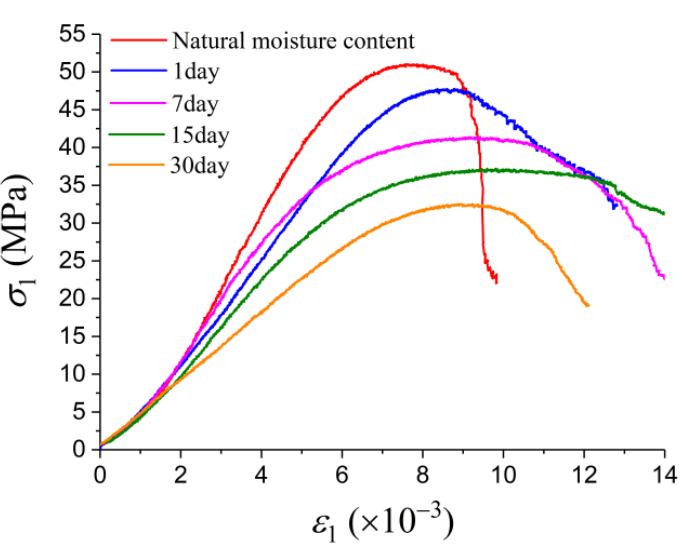
Figure 8. The stress-strain curves of the gypsum rocks after immersion in water for different durations. The relationship between the triaxial compressive strength and the water content of gypsum rock is shown in Figure 9, which indicates that the triaxial compressive strength of the gypsum rock declined with the increase in soaking time. After soaking in water for 30 days, the average compressive strength decreased significantly from 51.08 MPa to 31.21 MPa. After immersion in water for 1 day, the triaxial compressive strength of the gypsum rock was 48.87 MPa, this being 4.33% lower than that in the natural state. After immersion in water for 7 days, the triaxial compressive strength of the gypsum rock was 41.64 MPa, this being 18.48% lower than that in the natural state. After immersion in water for 15 days, the triaxial compressive strength of the gypsum rock was 36.56 MPa, this being 28.43% lower than that in the natural state. After immersion in water for 30 days, the triaxial compressive strength of the gypsum rock was 31.21 MPa, this being 38.90% lower than that in the natural state. In the initial stage of the water immersion, the compressive strength decreased considerably, and in the later stage, the declining trend gradually slowed down. This shows that the weakening effect of the water on the mechanical properties of the gypsum rock was very significant, especially in the initial stage of the water immersion. The relationship between the triaxial compressive strength of the gypsum rock and